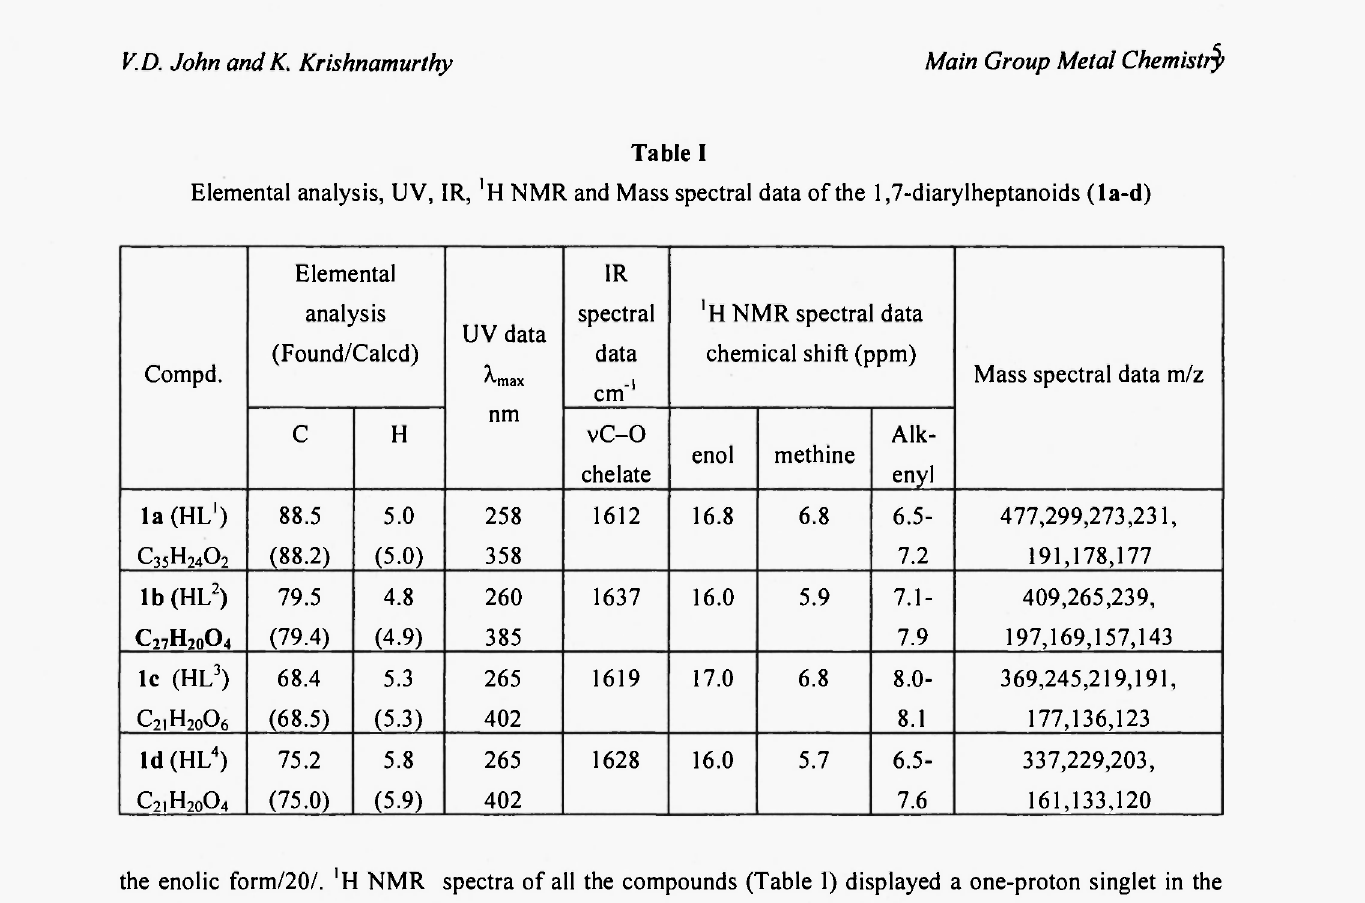
Elemental analysis, UV, IR, 'H NMR and Mass spectral data of the 1,7-diarylheptanoids (la-d)